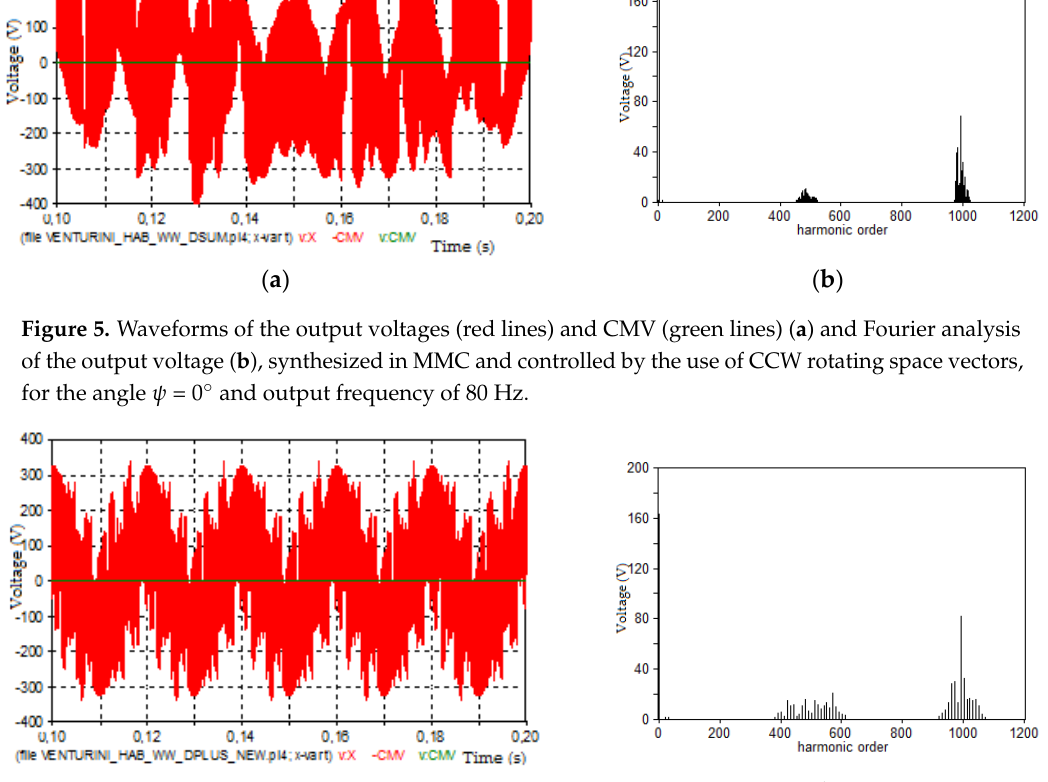
( b ) Figure 7. Waveforms of the output voltages (red lines) and CMV (green line) ( a ) and Fourier analysis of the output voltage ( b ), synthesized in MMC and controlled by the use of CW rotating space vectors, for the angle  = 0° and output frequency of 80 Hz.